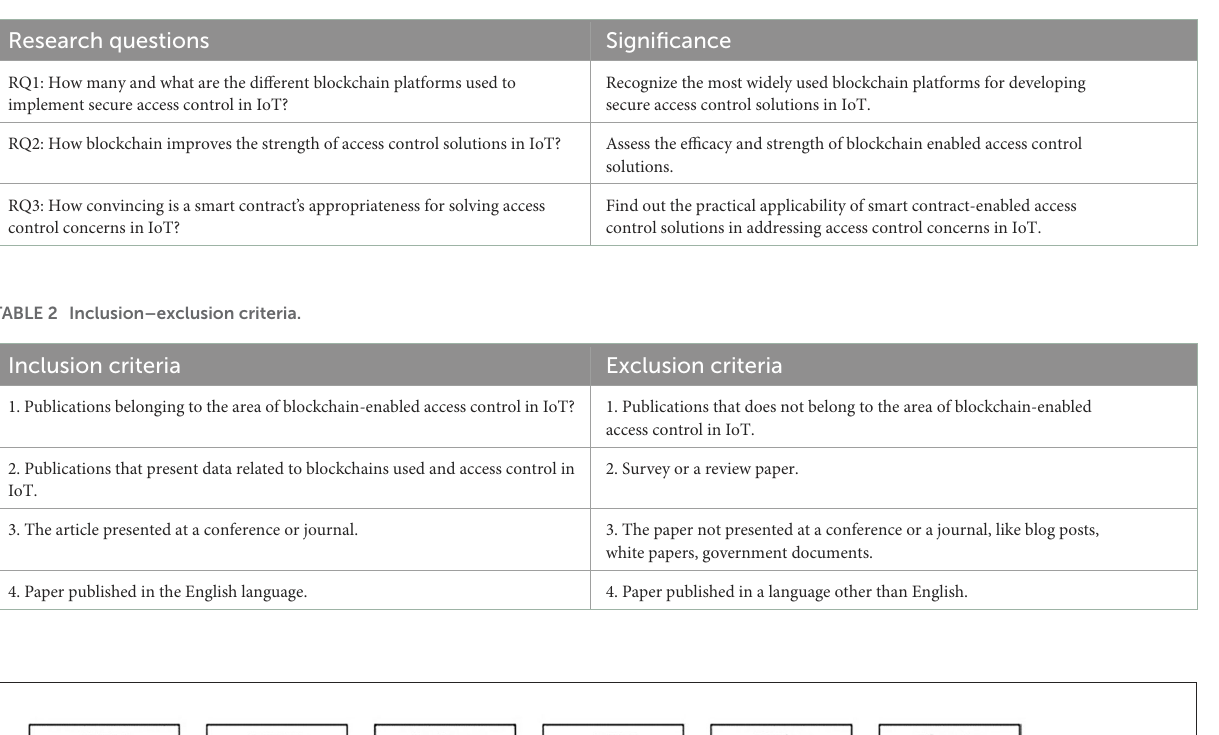
TABLE 1 Research questions.